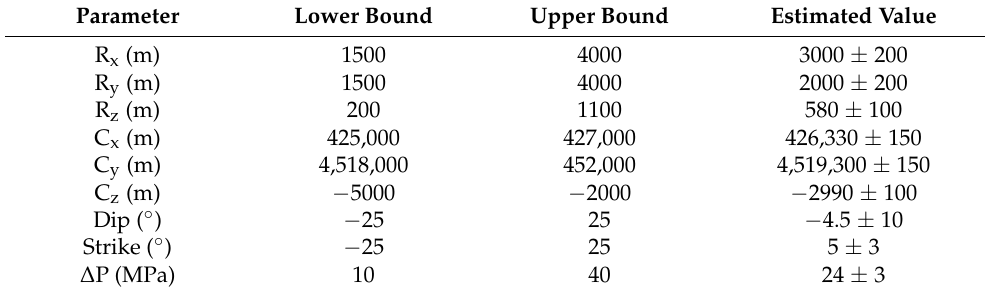
Table 1. Source parameters. R x,y,z : spheroidal axes; C x,y,z : source center; dip and strike: source orien- tation and pressure. Second and third columns: bounding of unknown parameters. Fourth column: estimated values with the related